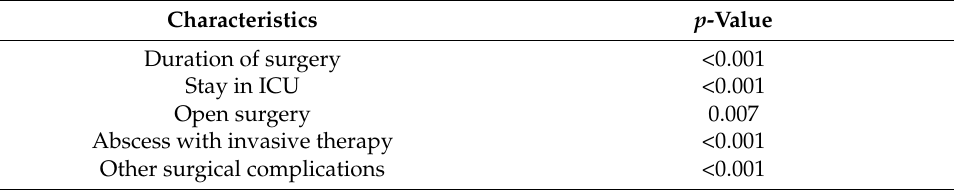
Table 5. Results of the multivariate analysis; ICU, intensive care unit.